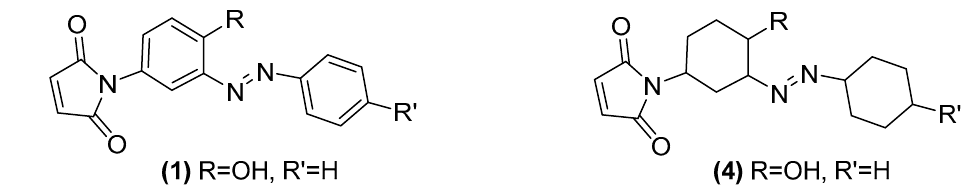
Figure 11. Example of possible source of error in reporting of formula for elemental analysis.